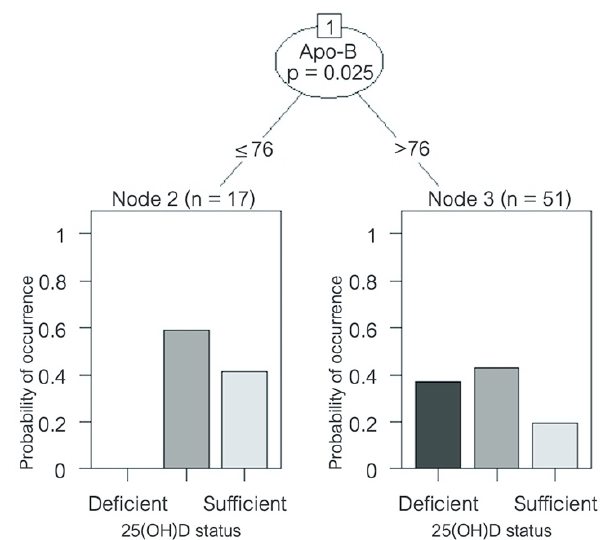
Figure 4. Decision tree predicting vitamin D status in patients with heart failure. Variable name and p -value is shown inside the circle; the corresponding lines show cut-off values. Bar graphs at the bottom show 25(OH)D status distribution amongst patients. Apo = apolipoprotein; sufficiency = 25(OH)D ≥ 30 ng/mL, insufficiency = 25(OH)D ≥ 20 and < 30 ng/mL, and deficiency = 25(OH)D < 20 ng/mL [30]. 25(OH)D = 25-hydroxyvitamin D.